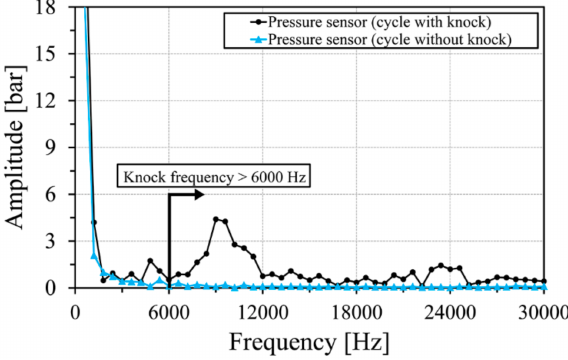
Figure 21. FFT spectrum of the pressure sensor signal between − 10 CA deg and +45 CA deg in case of knock and without knock at 5000 rpm and full